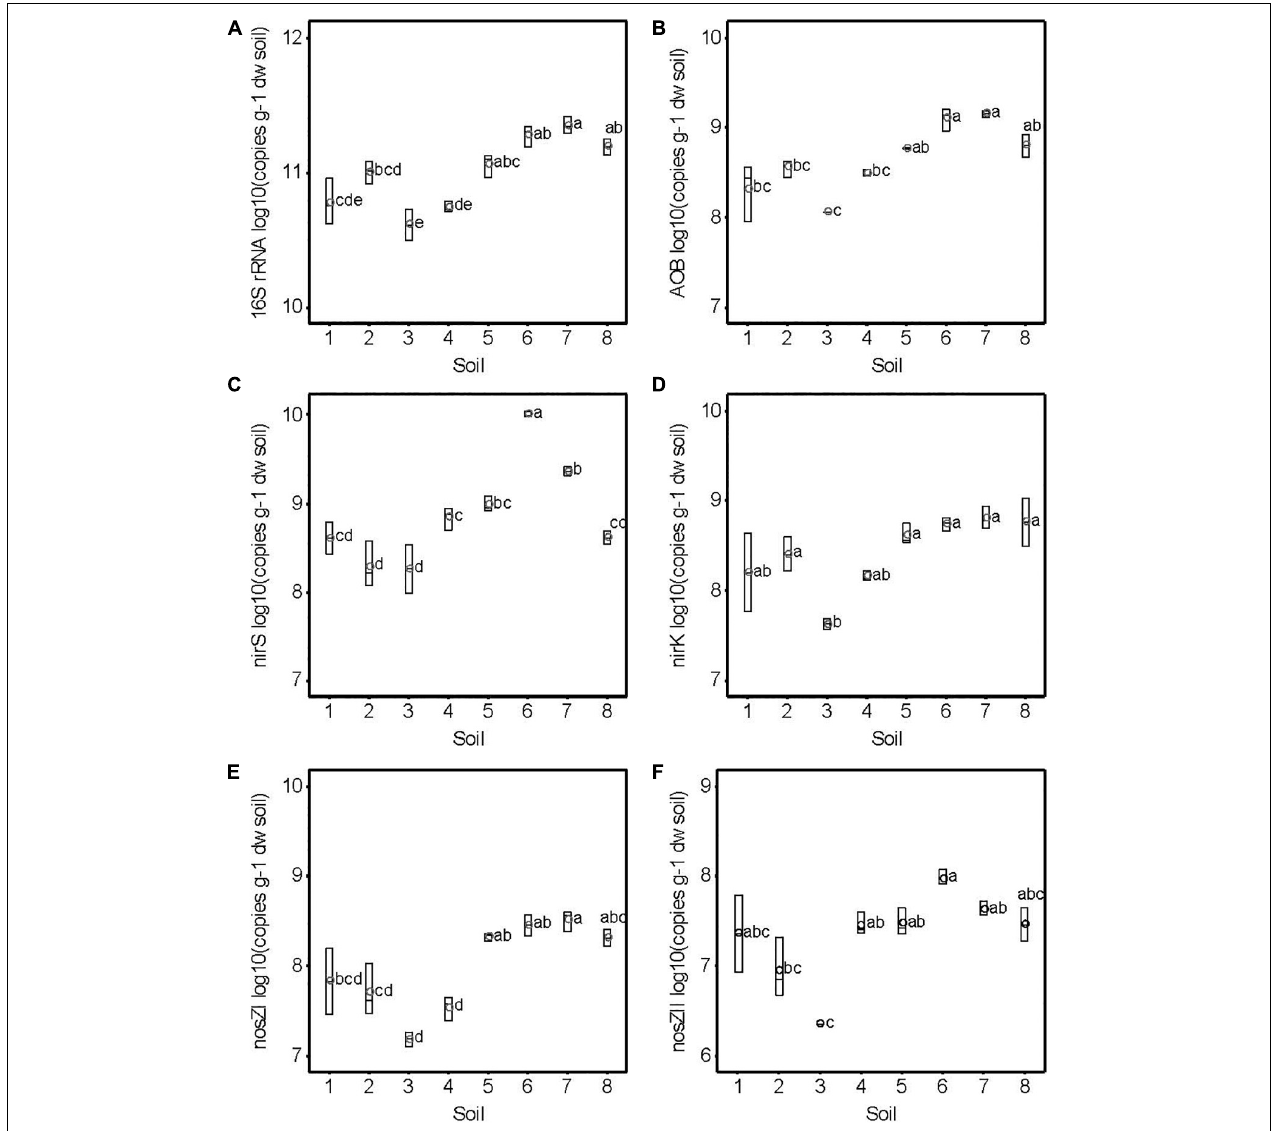
FIGURE 3 | Abundances of (A) 16S rRNA gene, (B) ammonia-oxidizing bacteria (AOB), (C) nirS , (D) nirK , (E) nosZ I, and (F) nosZ II (copies g − 1 dry soil) for the eight topsoils. Different letters denote significantly different values of the mean (open circle, n = 2–3, p < 0.05). Note the different